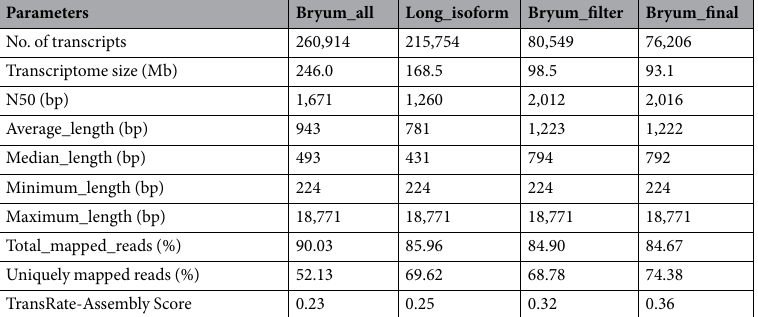
Table 1. Assembly, reads mapping and quality evaluation statistics for Bryum argenteum transcriptomes at each step of